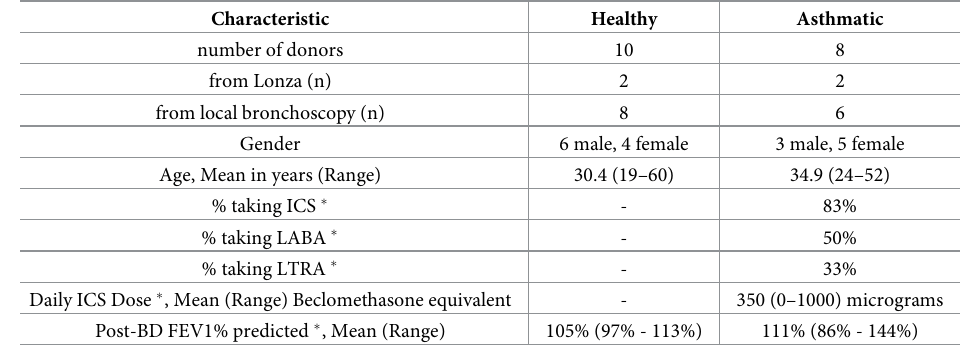
Table 1. Characteristics of donors of HBECs cultured in this